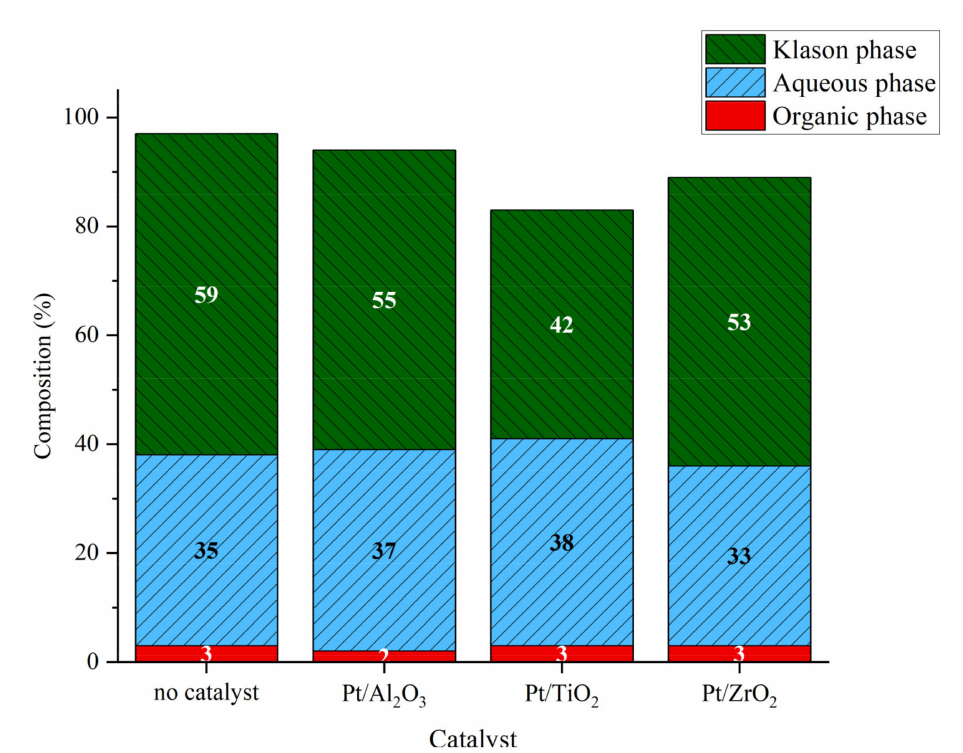
Figure 4. Phases composition after lignin catalytic liquefaction over platinum catalysts. Reaction conditions: Kraft lignin